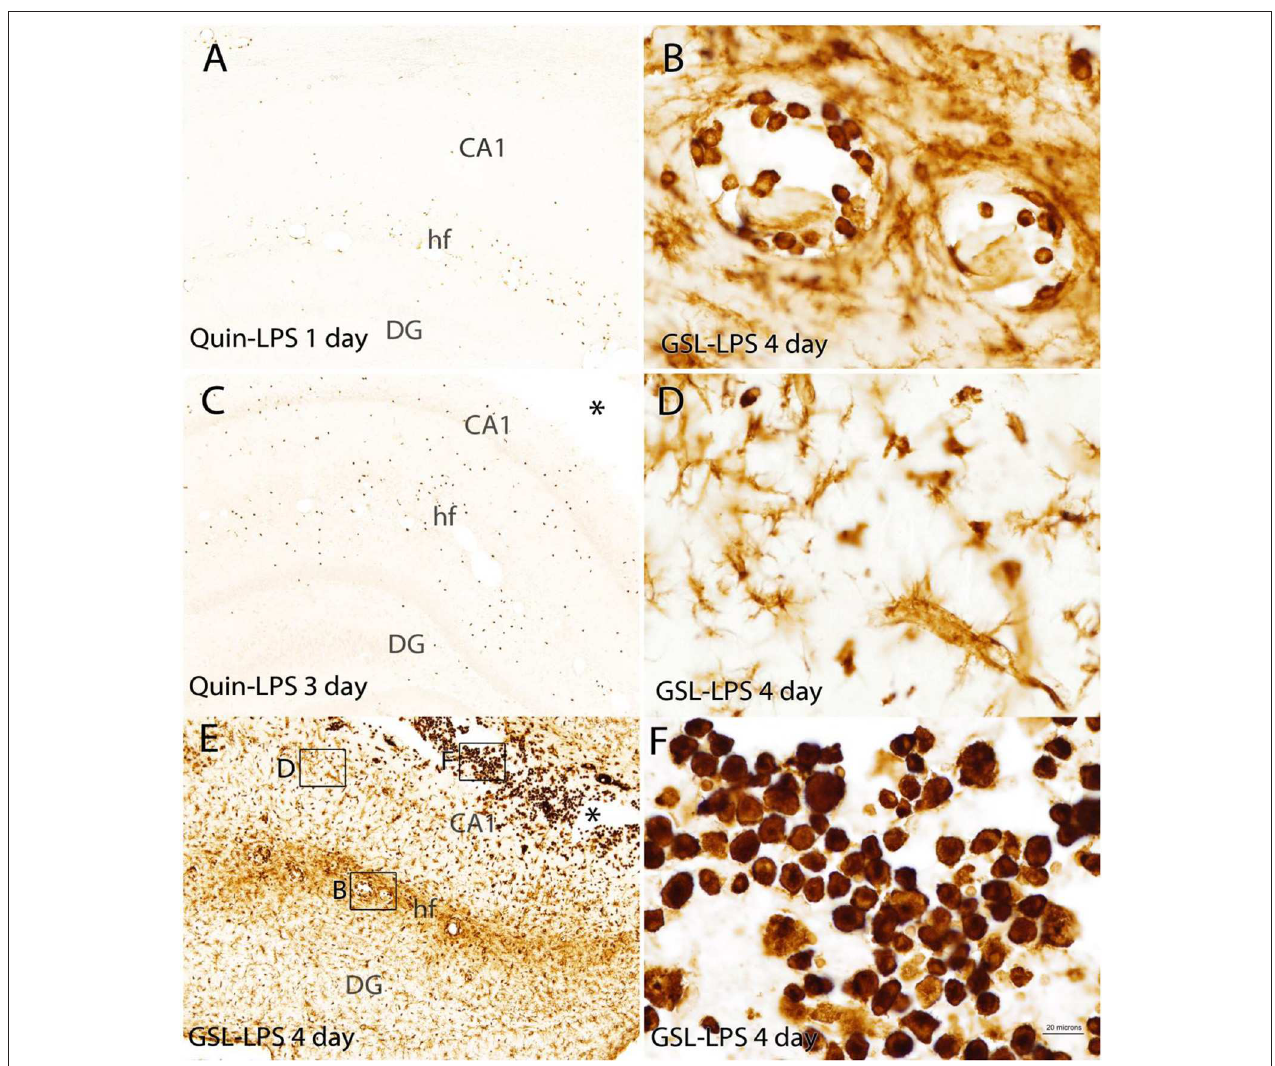
FIGURE 7 | Comparison of the Quin-IR and lectin (GSL) reactions in the hippocampus at several time points after LPS injection. Quin-IR at 1 and 3 days after LPS is shown in (A,C) . (E) Shows lectin staining for macrophages and activated microglia 4 days after LPS injection. (B,D,F) Show enlargements of the lectin staining in areas designated by the boxes in (E) . (B) Shows monocytes/macrophages adherent to the blood vessels in the hippocampal fissure. (D) Shows the strong activation of microglia in the CA1 region of hippocampus. (F) Shows the strong infiltration of phagocytes into the necrotic region (*) around the injection site. Bar in (F) , 200 µ m in (A,C,E) ; 20 µ m in (B,D,F) . CA1, CA1 region of hippocampus; DG, dentate gyrus; hf, hippocampal